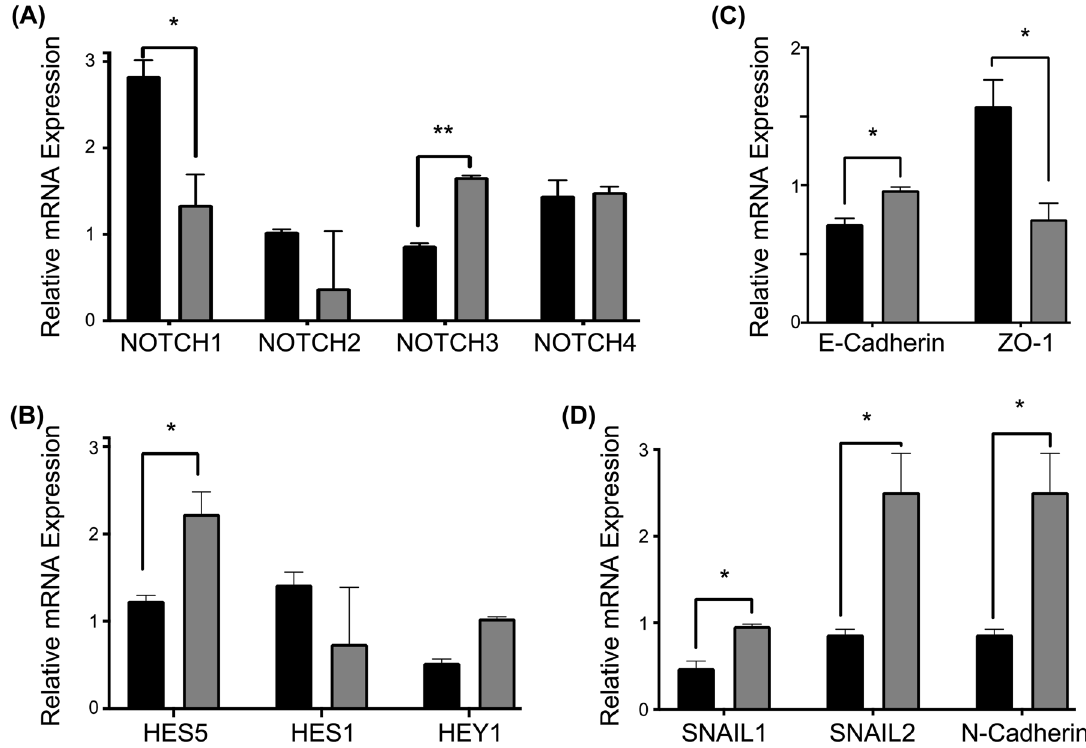
Figure 5: Expression analysis of notch pathway components and EMT markers. mRNA expression levels of (A) notch receptors (NOTCH 1,2,3 and 4), (B) notch pathway target genes (HES5, HES1, HEY1), (C) epithelial markers (E-cadherin, ZO-1), and (D) mesenchymal markers (SNAIL2, N-cadherin, andSNAIL1)ofMCF-7-CandMCF-7-Rcellsareshown.Datarepresentthemeansand ± SDofthreeindependentexperiments(ns:notsigni fi cant,*p<0.05, **p<0.01,